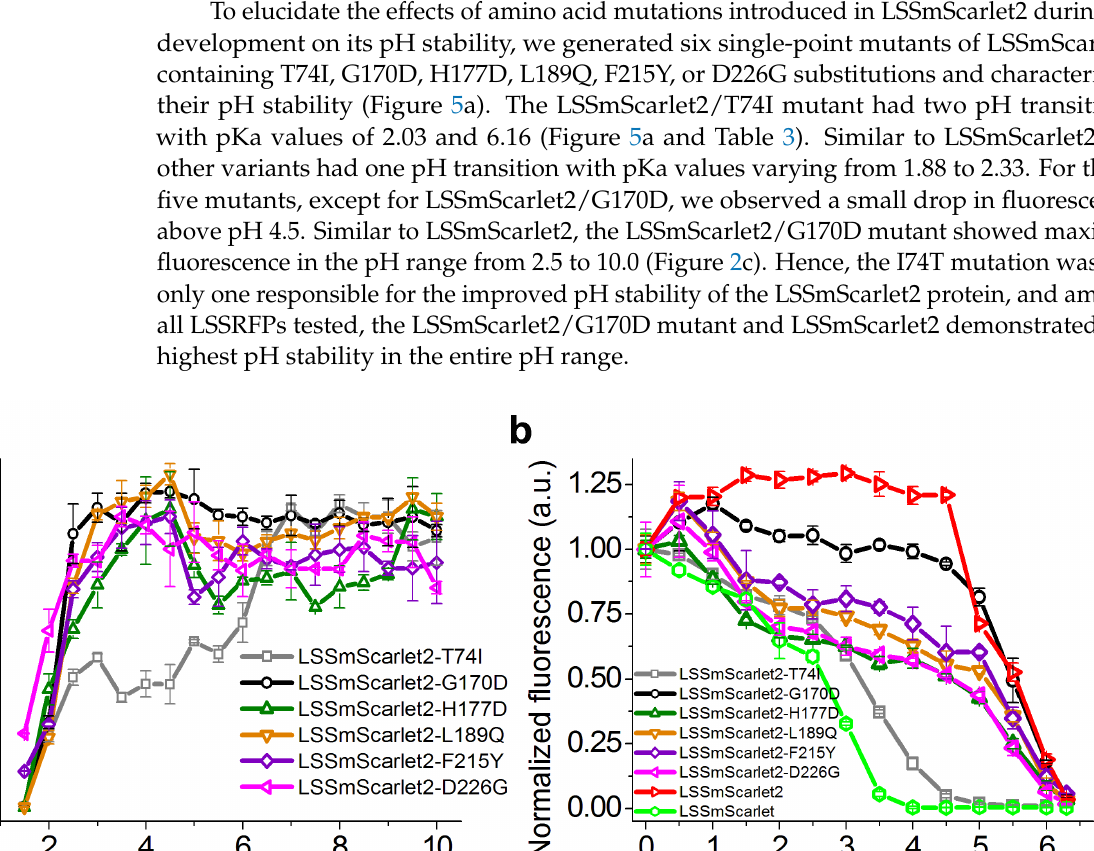
Table 3. pH stability and chemical stability of LSSmScarlet, LSSmScarlet2, LSSmScarlet3